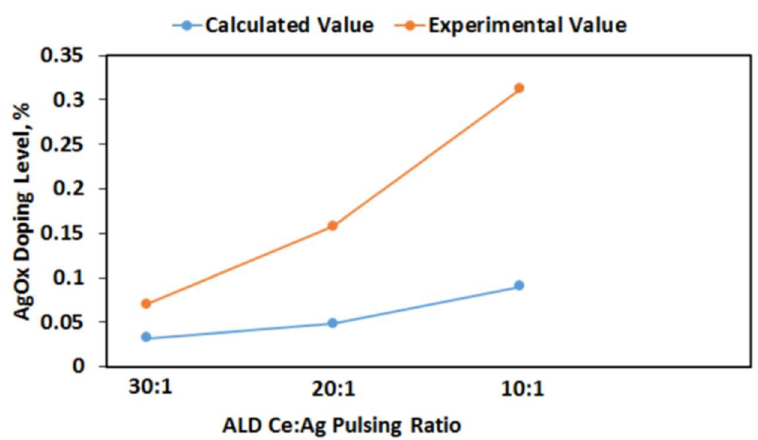
Figure 5. Relationship between CeO 2 :Ag pulsing ratio vs. silver molar percent in the corresponding Ag doped CeO 2 thin